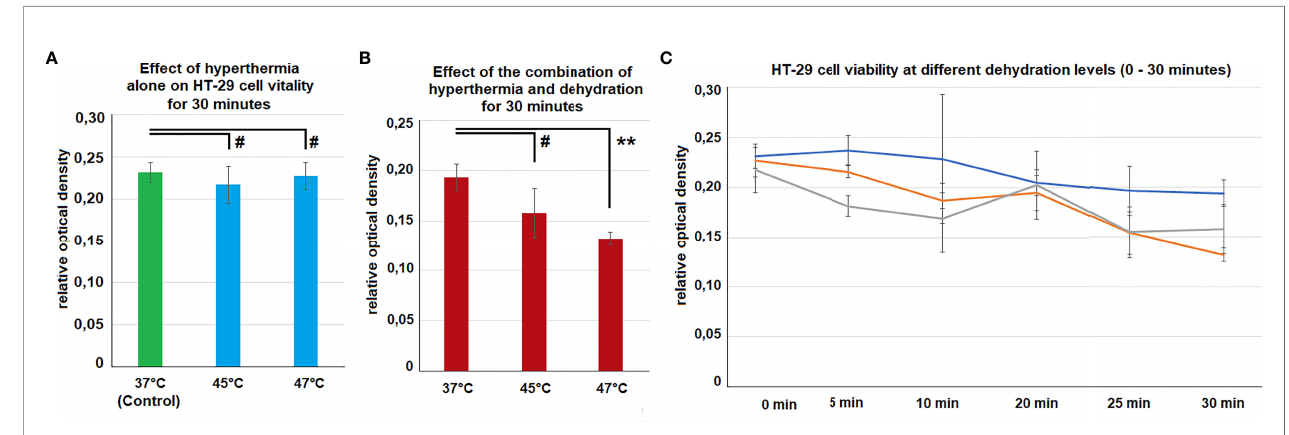
FIGURE 5 | (A) In vitro cell-viability of colon cancer cells after 30 minutes of hyperthermia (without dehydration) at 45°C and 48°C. Control cells were only exposed to the physiological temperature of 37°C. (B) In vitro cell-viability of colon cancer cells after 30 minutes of hyperthermia and dehydration at 37°, 45°C and 48°C. (C) Course of cell viability following different exposure times of dehydration and hyperthermia 0 (Control), 5, 10, 20, 25 and 30 minutes. Signi fi cance levels: #=p>0.05,**=